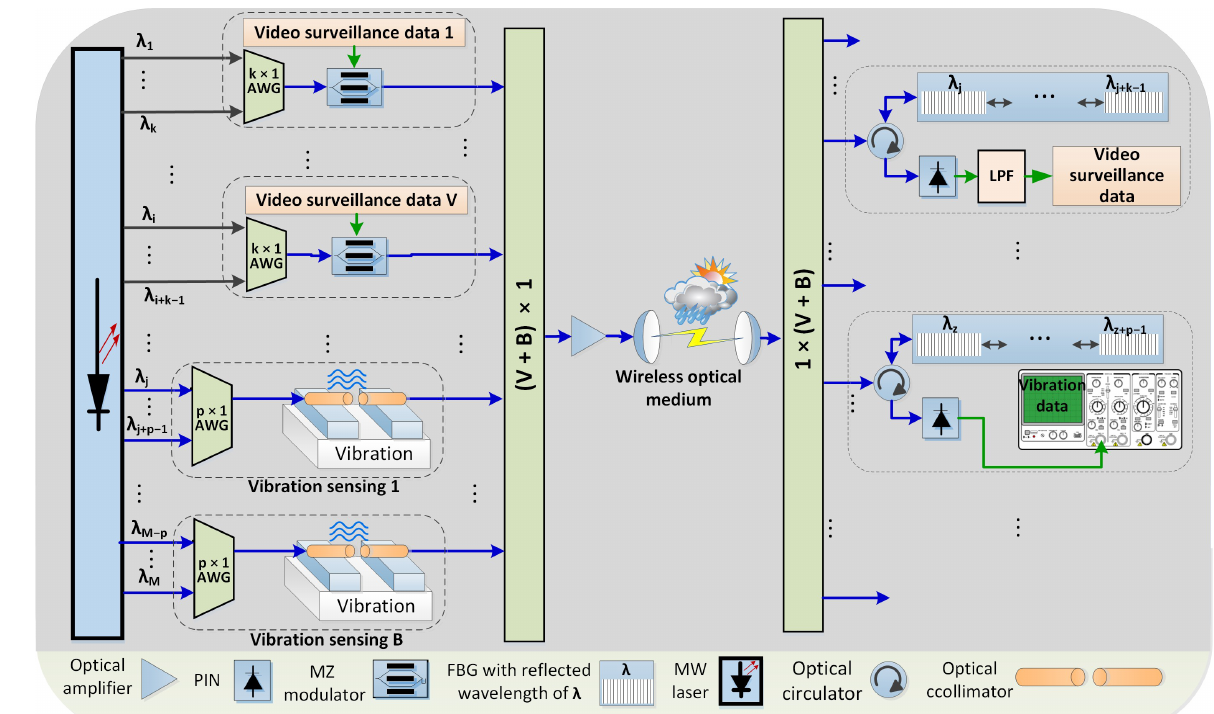
Figure 1. Diagram of WON-OCDMA hybrid system for video surveillance and vibration sensing monitoring.